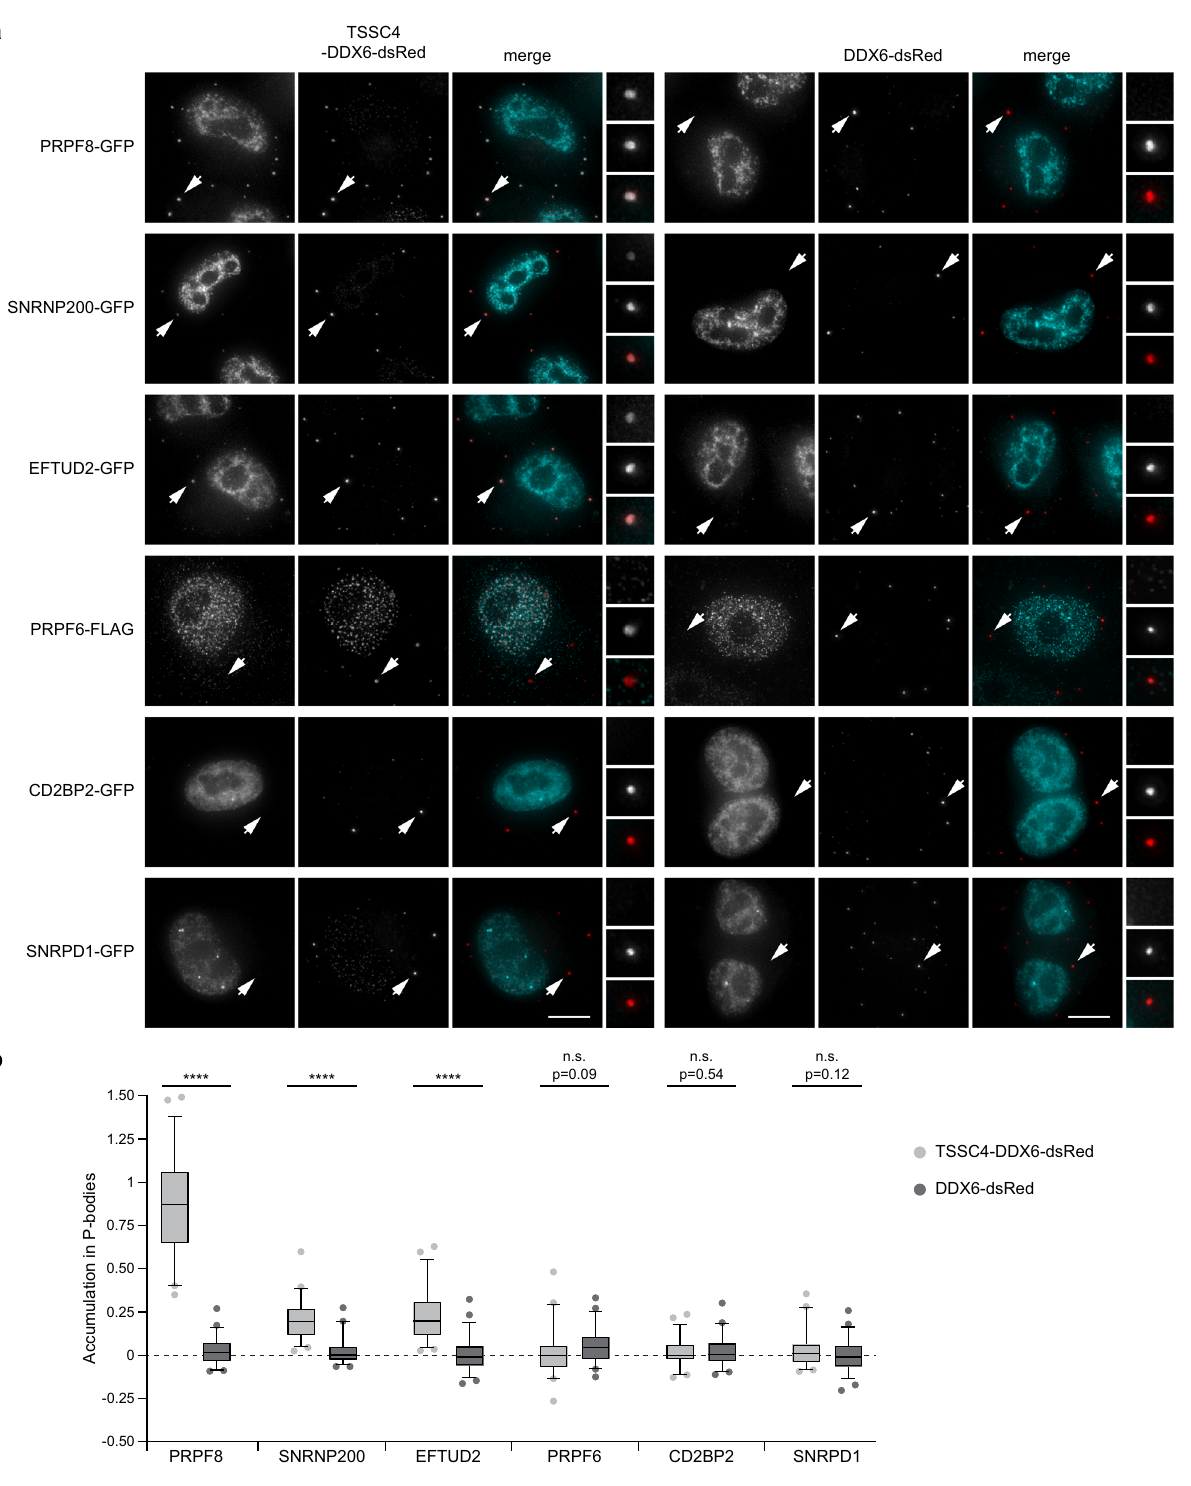
Fig. 4 TSSC4 interacts with PRPF8, SNRNP200, and EFTUD2 in the cytoplasm. a HeLa cells co-transfected with TSSC4-DDX6-dsRed fusion protein (red) and U5-speci fi c proteins tagged with GFP or FLAG (turquoise). The DDX6/p54 peptide targets the TSSC4-DDX6-dsRed protein into cytoplasmic P- bodies. Co-recruitment of individual U5 proteins (PRPF8, SNRNP200, and EFTUD2) into P-bodies indicates their interaction with TSSC4. P-bodies marked by arrows are enlarged three times in insets. Scale bar represents 10 μ m. b Quanti fi cation of P-body localization. The signal of GFP/FLAG-tagged U5- speci fi c proteins in P-bodies was corrected by subtraction of the signal in the surrounding cytoplasm and compared to the signal in the nucleus. In total, 50 P-bodies were analyzed for each condition and shown in a box blot (center line — median; box limits — 1st and 3rd quartiles; whiskers — 5th and 95th percentile), two lowest and two highest values are depicted as separate dots. Statistical signi fi cance was determined by the two-tailed T test, and all P values lower than 0.0001 are indicated by ****. Original values for box plots are provided in the Source Data fi